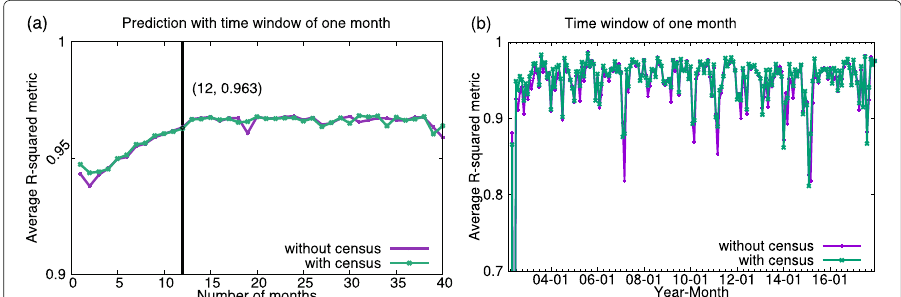
Fig. 3 Quality of prediction of the numbers of crimes. a Impact of the size of historical data. The plot shows the crime prediction accuracy for future time window size of one month as a function of the various lengths of historical data. The prediction accuracy improves with the increasing size of data the most for